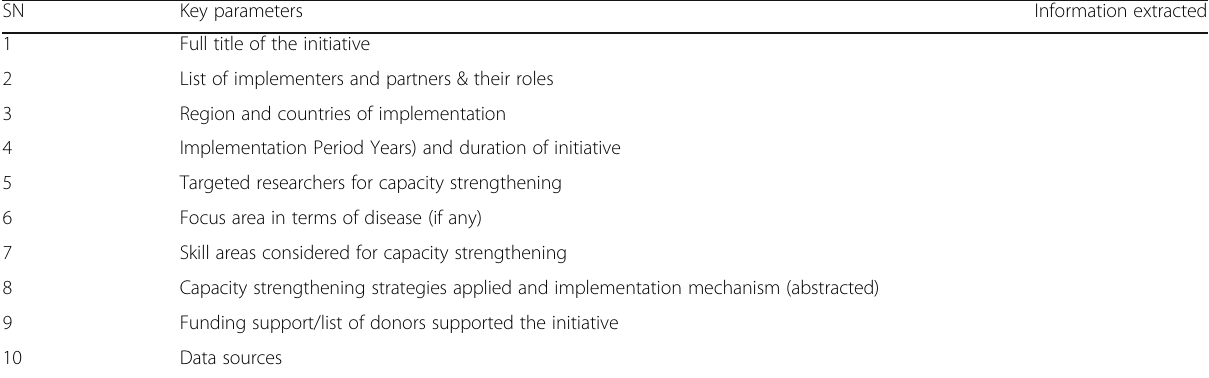
Abbreviations AACR-AORTC: American Association for Cancer Research and African Organisation for Research and Training in Cancer (AACR - AORTIC); AIIMS: All India Institute of Medical Science; ANPPA: Analysis of Non-communicable Diseases Prevention Policies in Africa; APCDR: African Partnership for Chronic Disease Research; APHRC: African Population and Health Research Center; ASCEND: ASian Collaboration for Excellence in Non-Communicable